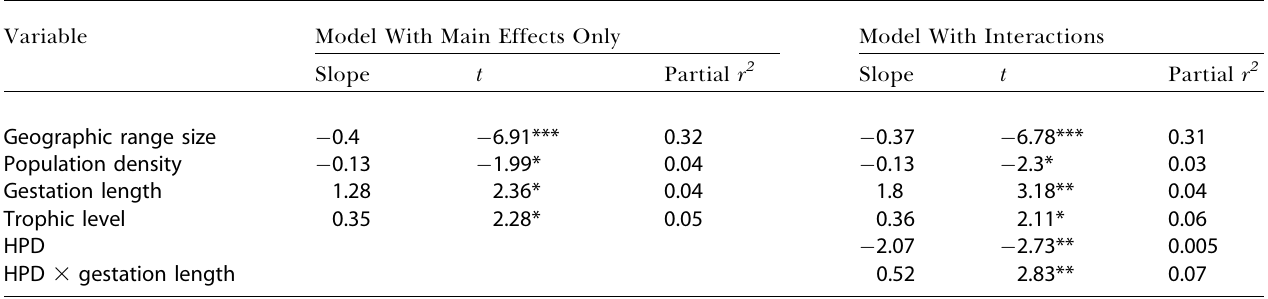
Table 2. MAMs from Multiple Regression of HPD and Biological Predictors of Extinction Risk in Carnivores Variable Model With Main Effects Only